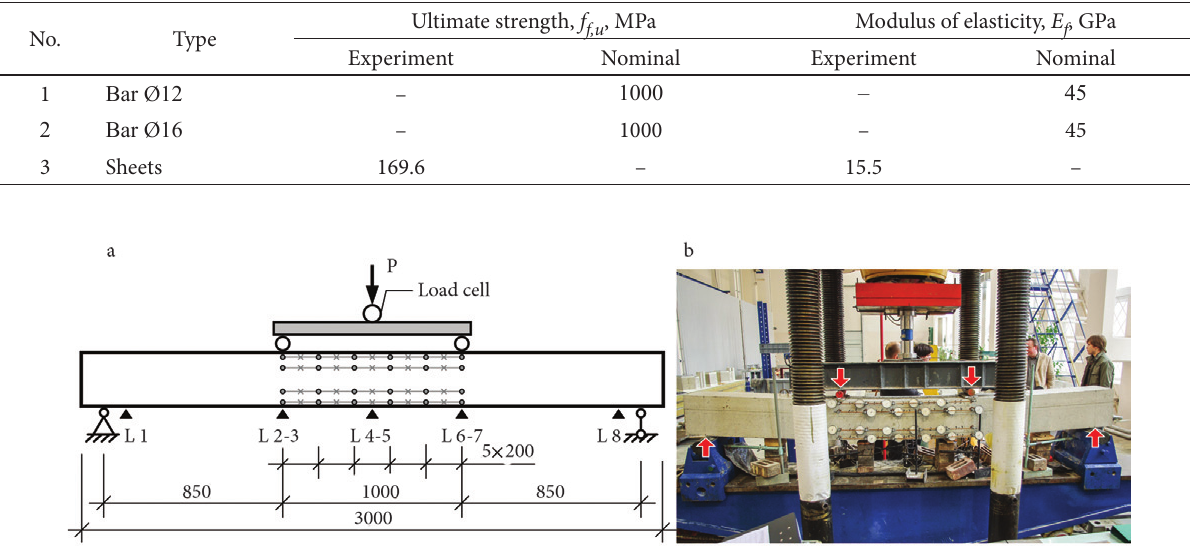
Fig. 2. Test set-up: a – layout of mechanical strain gauges and LVDT; b – test set-up